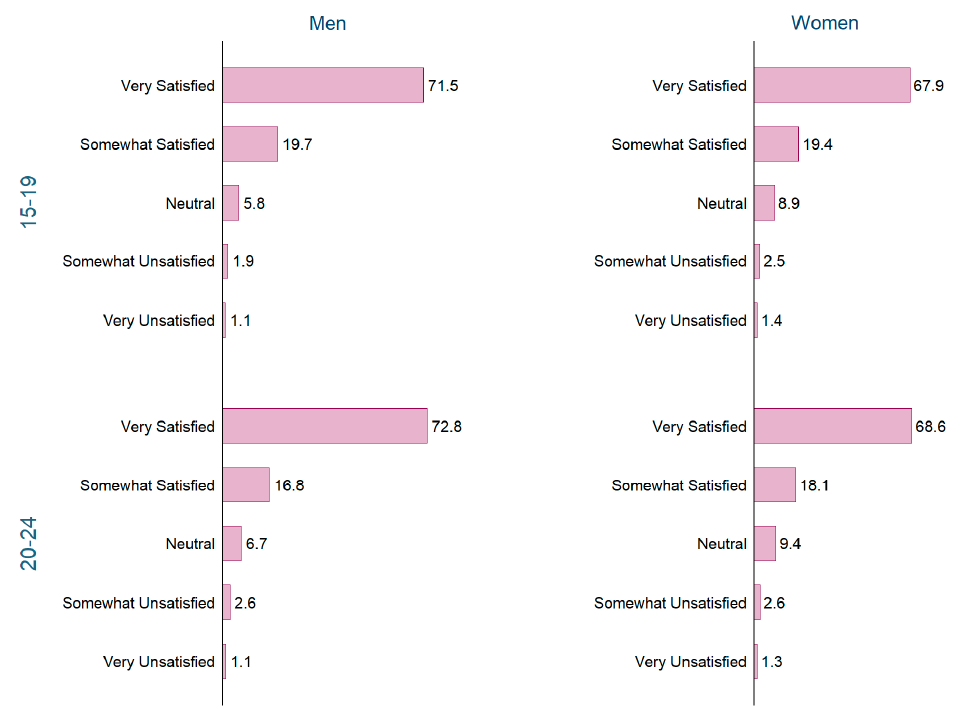
Figure 3. Proportion of men and women by self-reported health status.